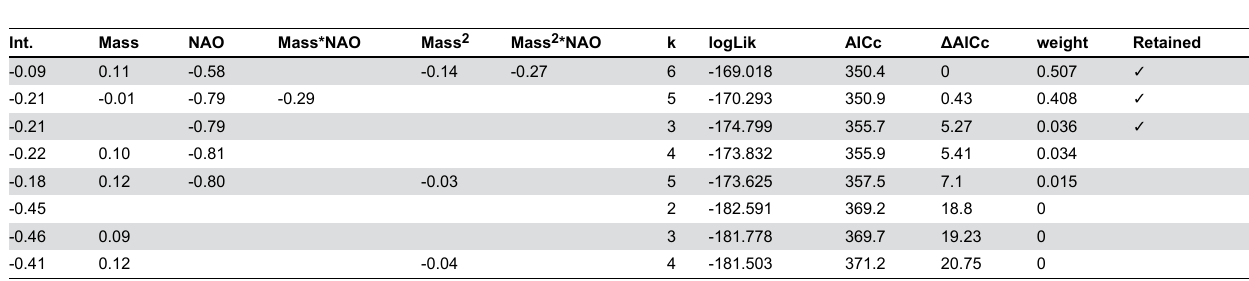
Table 2. Eight models investigating the factors that predict variation in reproductive success among light-bellied Brent geese, ranked by